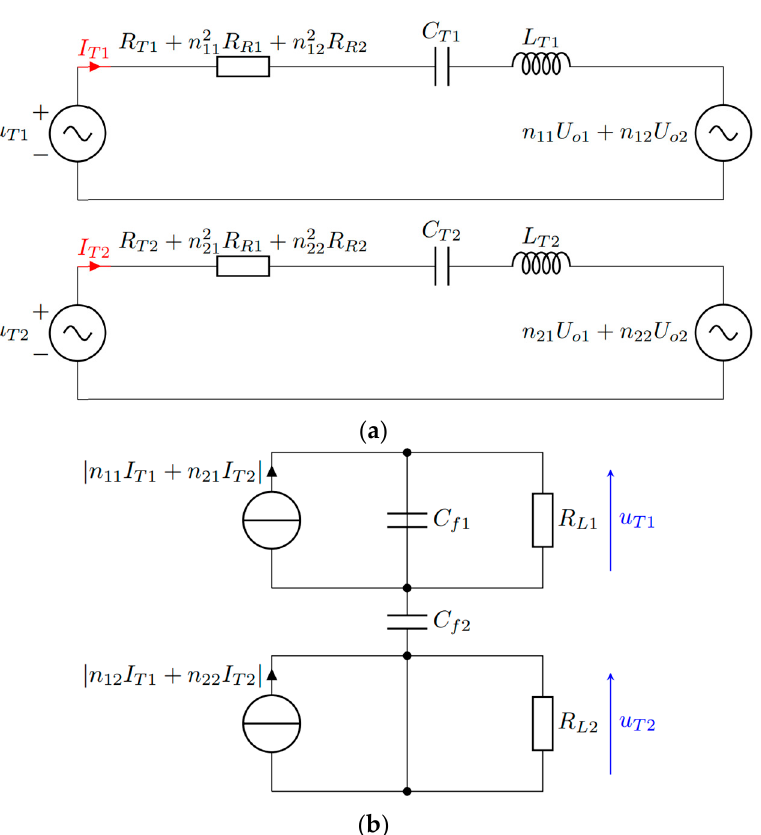
Figure 5. Reduced circuit of the IPT system for model derivation: ( a ) resonator circuit, ( b ) rectifier circuit.